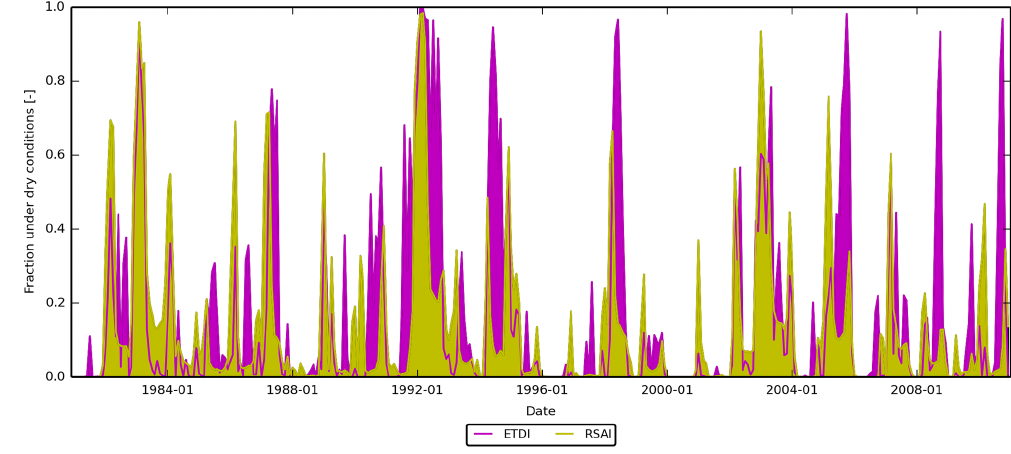
Figure 3. Fraction of the Limpopo Basin under moderate to extreme droughts represented by the indicator value (Iv < − 1.0).